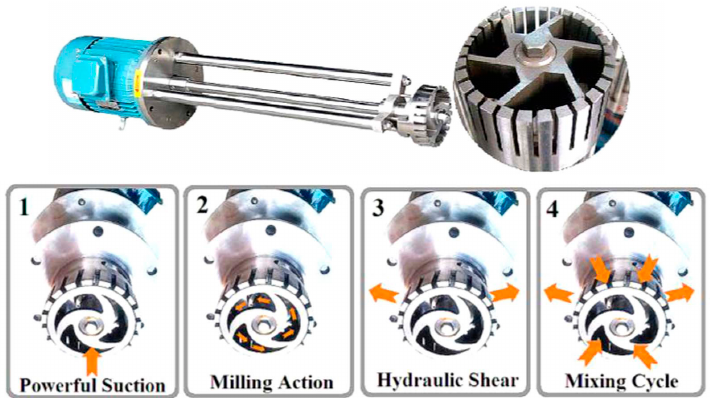
Figure 30. Schematic illustration of the exfoliation process using a high shear colloidal mixer. Reproduced from [24]. Copyright Springer, 2017.